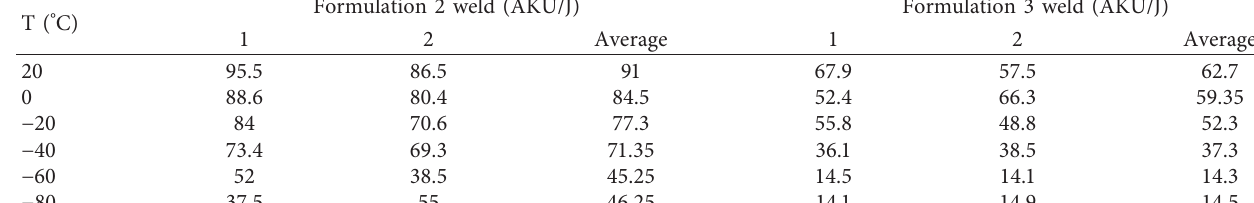
Table 4: Charpy impact energy (Ak) of U71Mn ultranarrow rail welds.